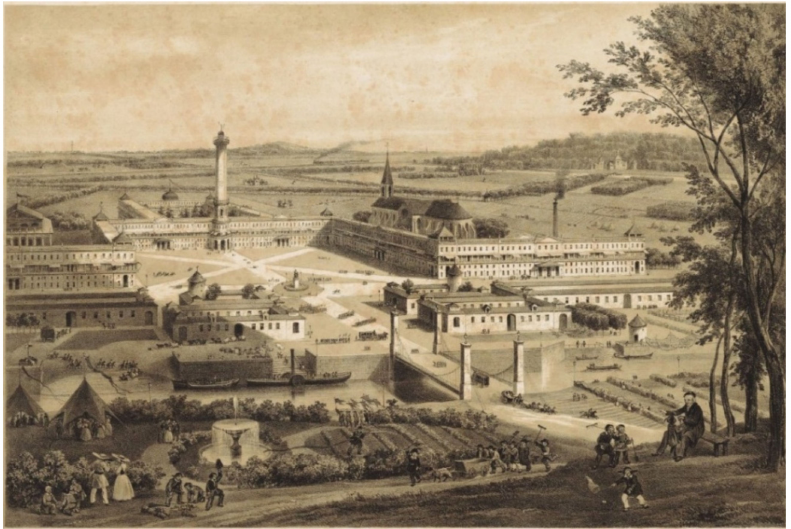
Figure 1. View of the phalanstery (lithograph by Fug è re H.), (Fug è re H., Vue d’un phalanst è re, village français [compos é ] d’apres la th é orie soci é taire de Ch. Fourier , date uncertain, but from 19th century. Soc 860.05, Houghton Library, Harvard